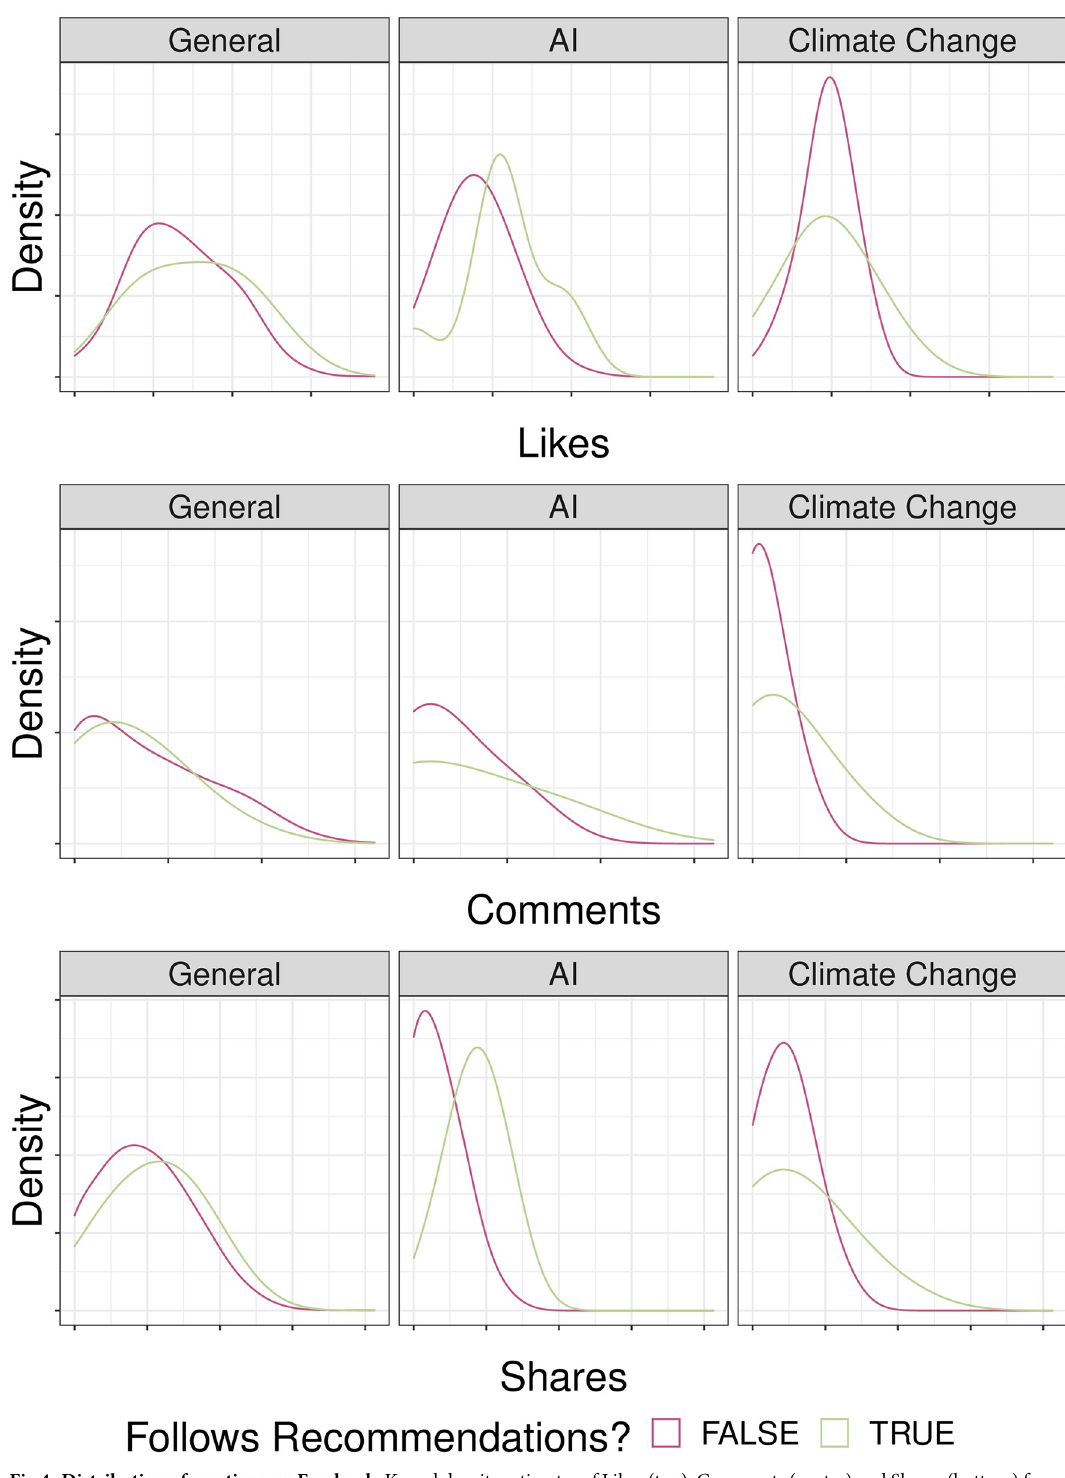
Fig 4. Distribution of reactions on Facebook. Kernel density estimates of Likes (top), Comments (centre) and Shares (bottom) for each of the four topics on Facebook. The topic Vaccines is missing due to the limited number of posts.